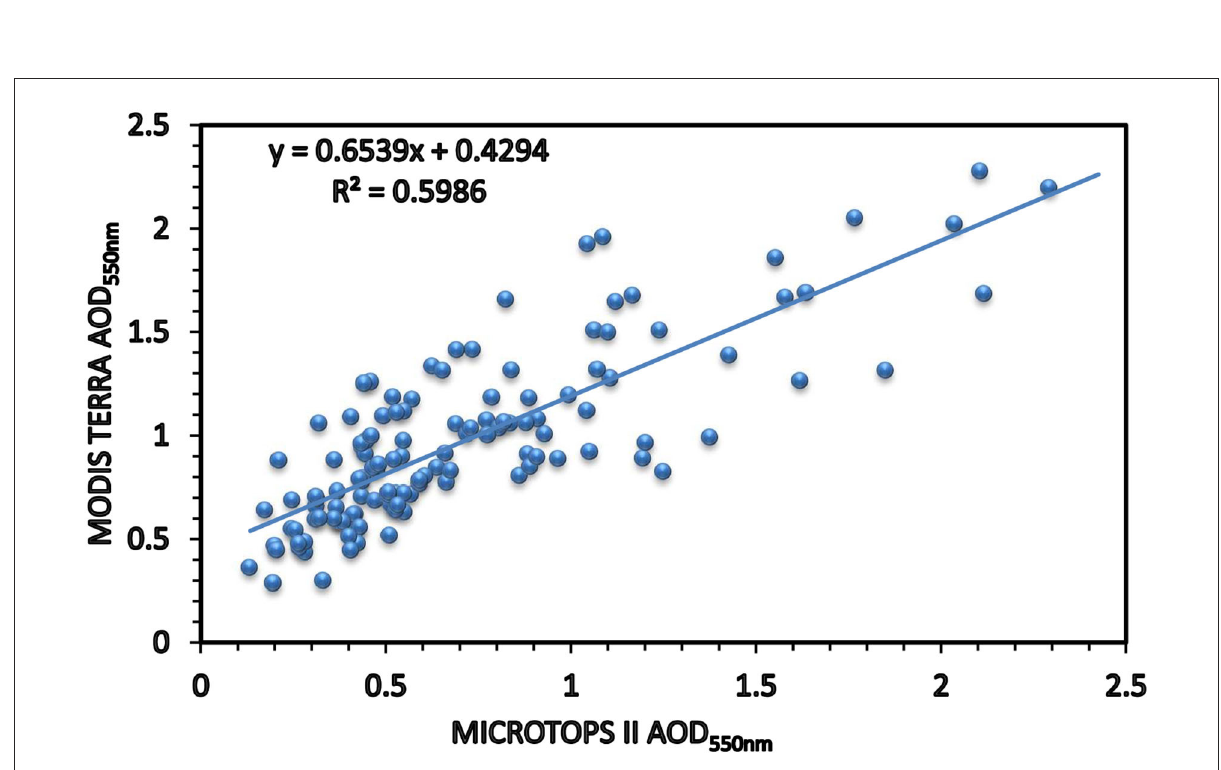
FIGURE8 Validation of level 3 MODIS AOD over Varanasi using MICROTOPS-II AOD, at 550nm, during the study period (April 2019–March 2020).